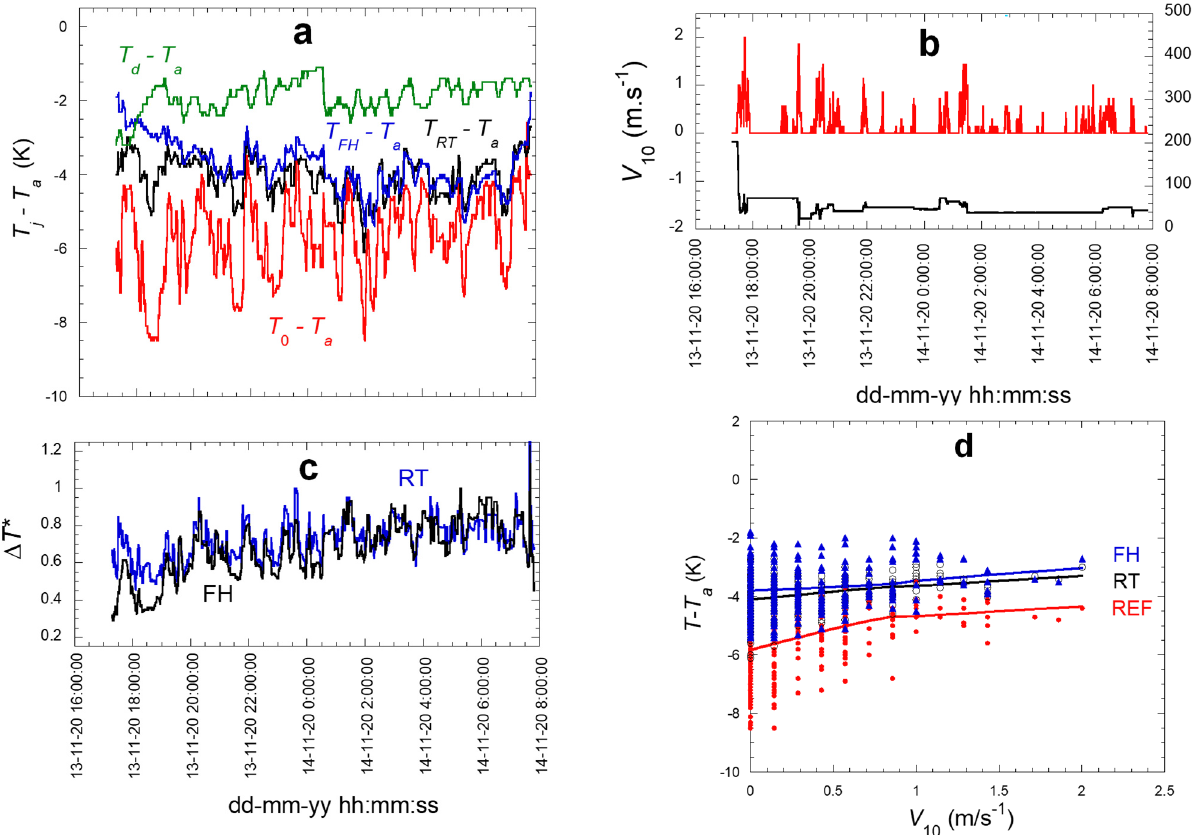
Figure 9. Recorded data for the reference condenser ( T 0 ) and rooftop and front hood on the AD car for the night 13–14 November 2020 (hh:mm:ss, UT + 1) in Ajaccio. ( a ) Differences with air temperature T a of the temperatures of reference ( T 0 ), rooftop ( T RT ), and front hood ( T FH ). ( b ) Corresponding windspeed V and wind direction Dir V . ( c ) Cooling efficiency ratio ∆ T ∗ and ∆ T ∗ (roof top and front RT FH hood, respectively). ( d ): Roof top and front hood cooling ( T RT,FH − T a ) with respect to air temperature T a as a function of windspeed V 10 extrapolated at 10 m from the ground. Curves are smoothing functions. During this night, dew yields were (REF) h REF = 0.197 mm, (RT) h RT = 0.148 mm and